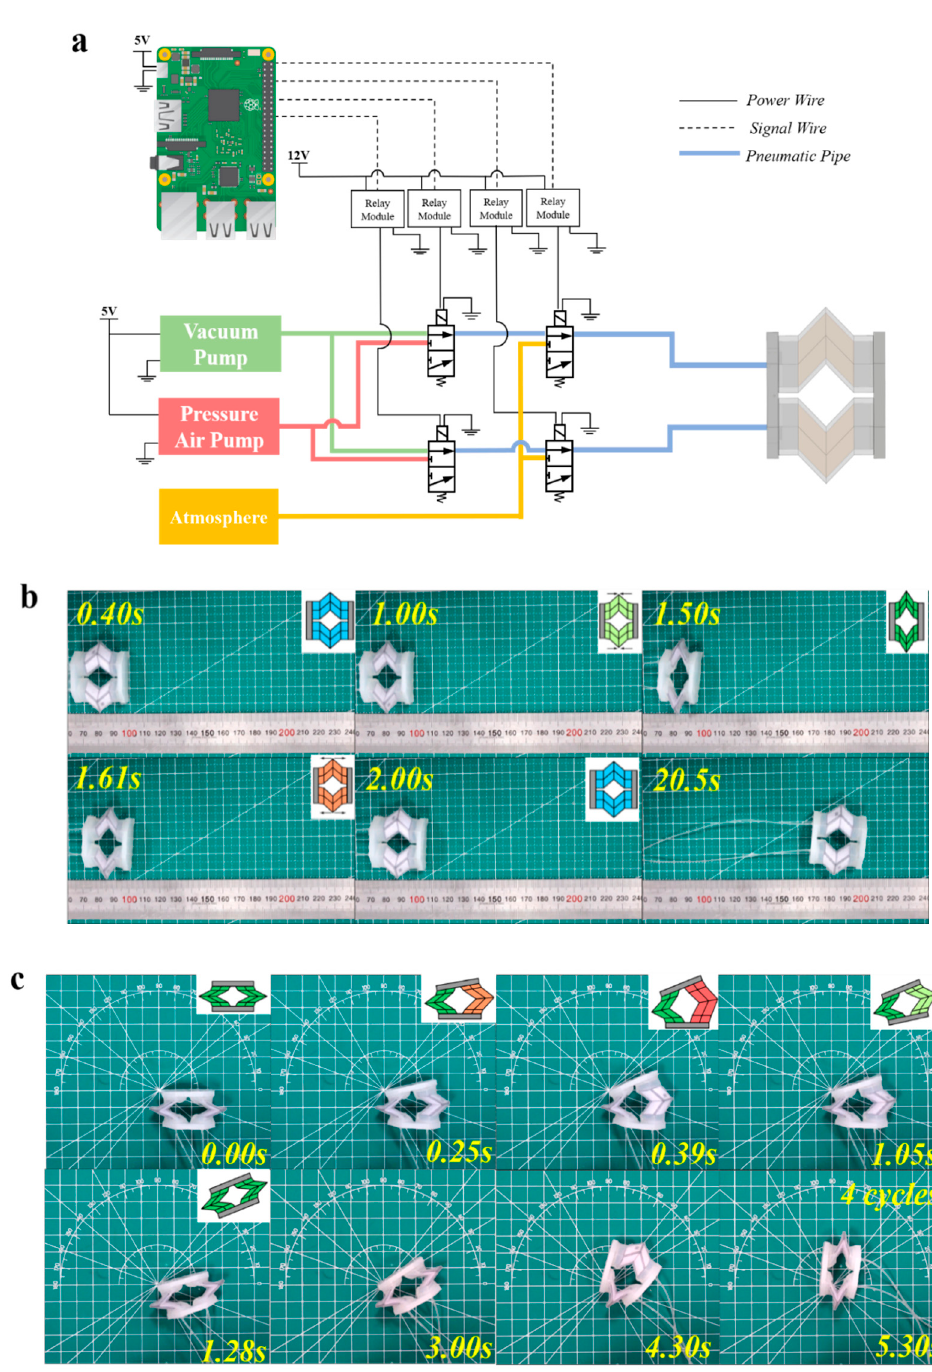
Figure 9. (a) The experimental setup for controlling the crawling robot; (b) The linear movement of the crawling robot; (c) The turning movement of the crawling robot. crawling robot; ( c ) The turning movement of the crawling